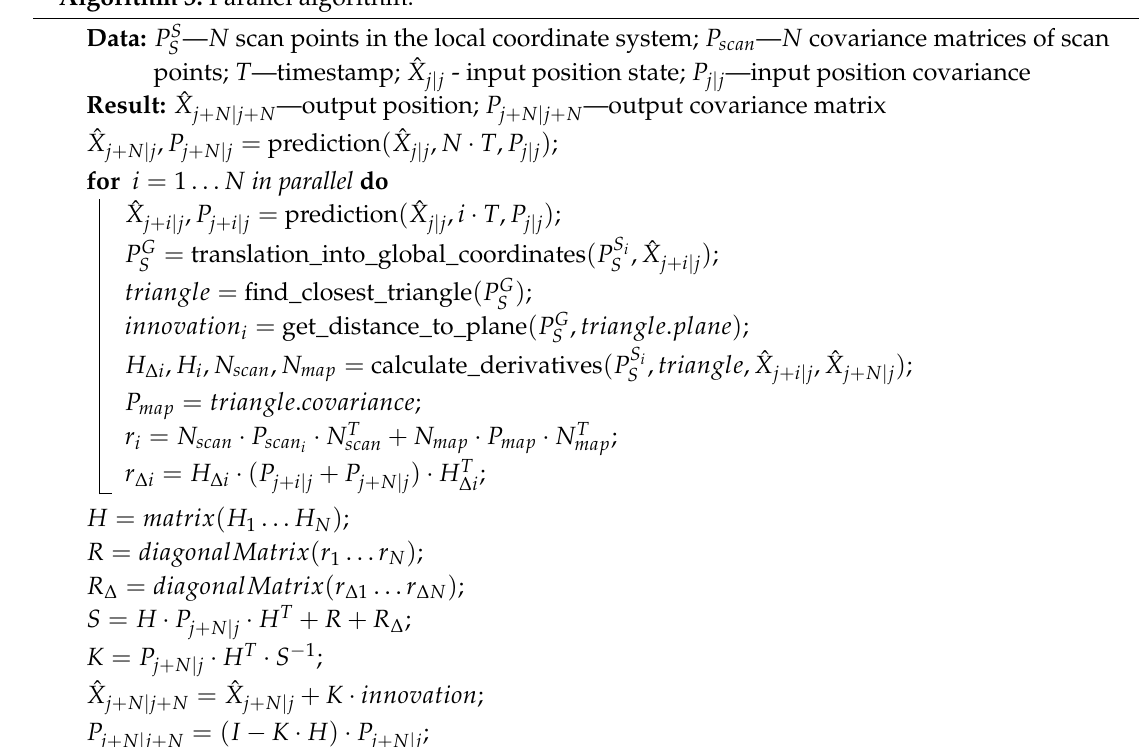
Algorithm 3: Parallel